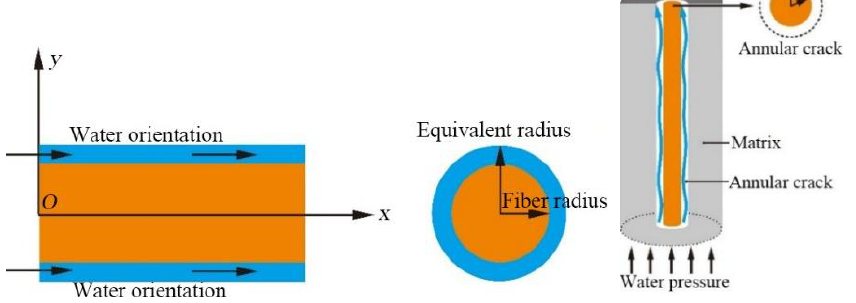
Figure 16. Concentric annular crack of fiber bundle.